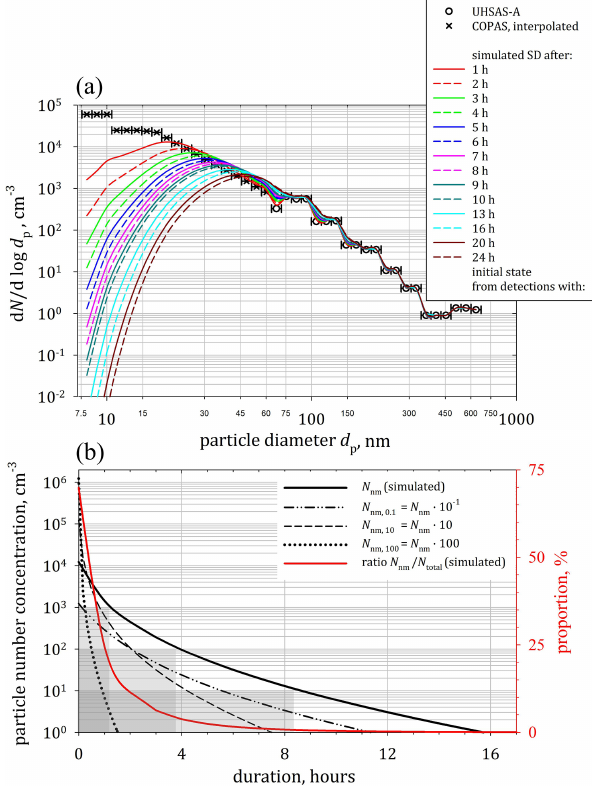
Figure 7. Results of a coagulation simulation based on the assump- tion of a distinct and expired burst-like event. The simulation’s initial particle size distribution (black circles; horizontal bars in- dicate the width of each size bin) is merged from data of three COPAS detectors (for N 6 , N 10 , and N 15 ) and of the UHSAS-A (65nm <d p < 1µm) as detected during NPF encountered on 4 Au- gust 2017, between 04:04:40 and 04:05:06UTC. (a) The processing particle size distribution (coloured lines) over several hours. (b) The concentration of nucleation-mode particles ( N nm ) over the simu- lation’s runtime and its fractional contribution to the total particle number concentration ( N total ). Furthermore, the simulated decay of variably multiplied N nm (by factors of 0.1, 10, and 100) as initial in- put of the simulation under constant background conditions (dashed